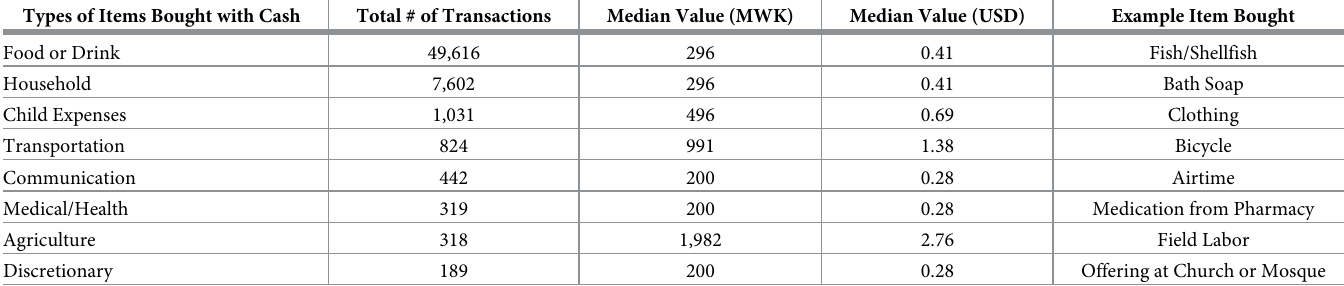
Table 5. Breakdown of outflows by